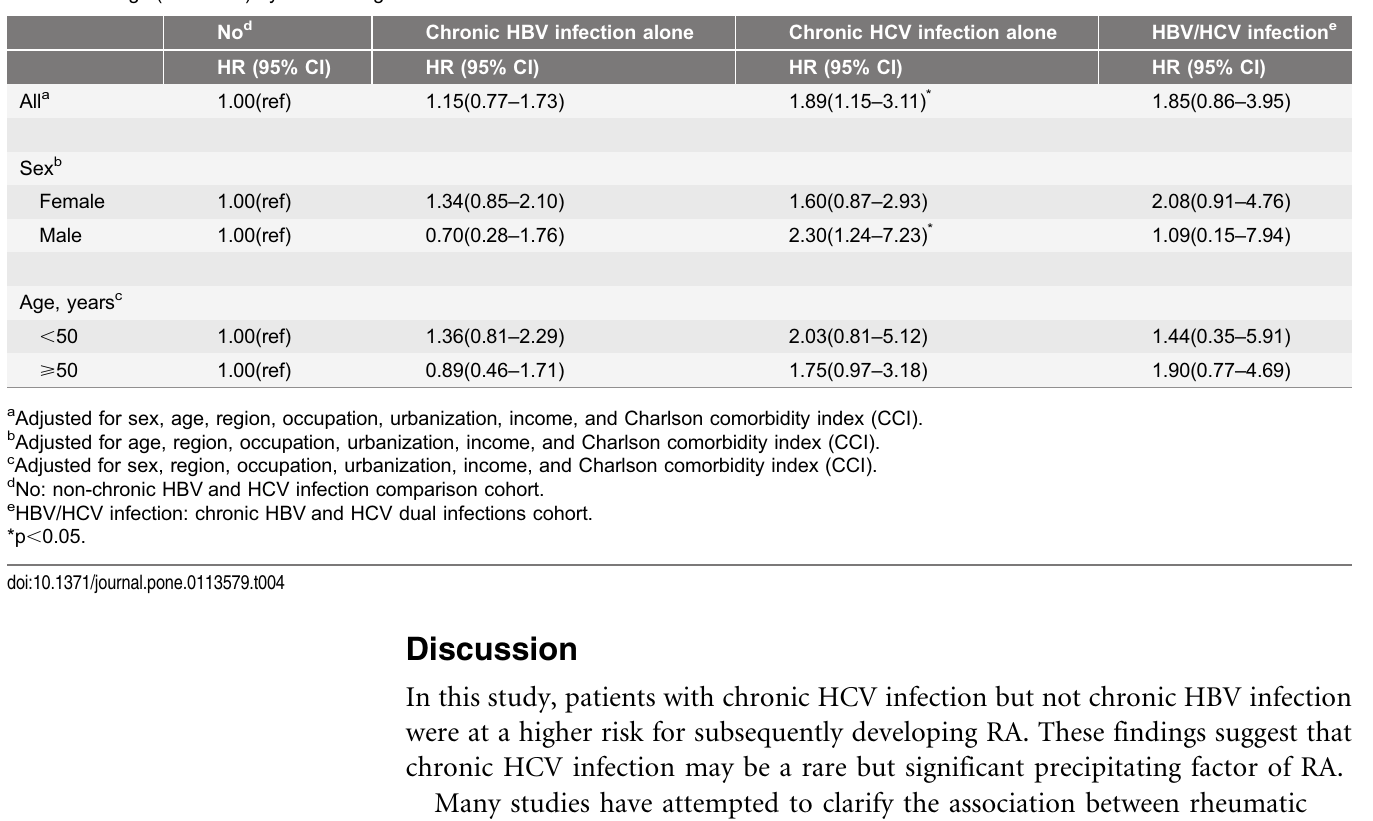
Table 4. Adjusted hazard ratios for rheumatoid arthritis (RA) among subjects with chronic hepatitis virus infection and prescribed disease-modifying anti- rheumatic drugs (DMARDs) by sex and age.